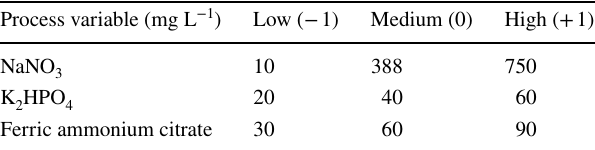
Table 1 Levels of three independent variables used in RSM in terms of actual and coded factors of Box–Behnken